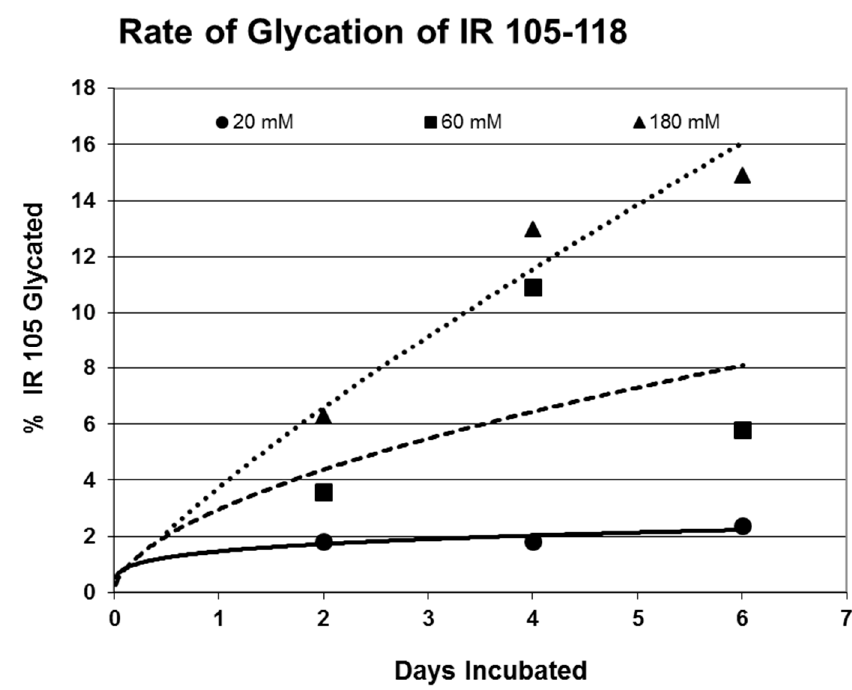
Figure 5. Rate of glycation of IR 105–118 at various concentrations of glucose as determined by MALDI-TOF.